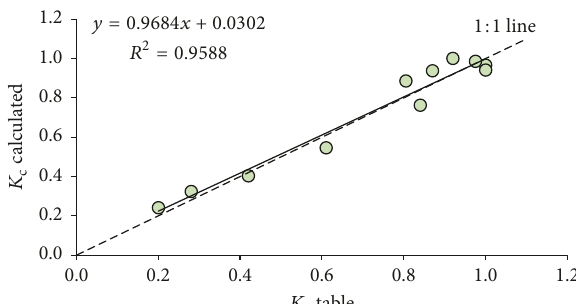
Figure 8: Relationship between 𝐾 c calculated and 𝐾 c tabulated for corn during 2014 growing season. The dashed line indicates the 1: 1 line.